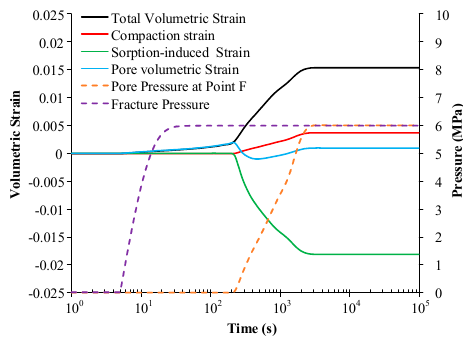
Figure 9. Evolution of volumetric strain and pore pressure at Point F, together with fracture pressure.